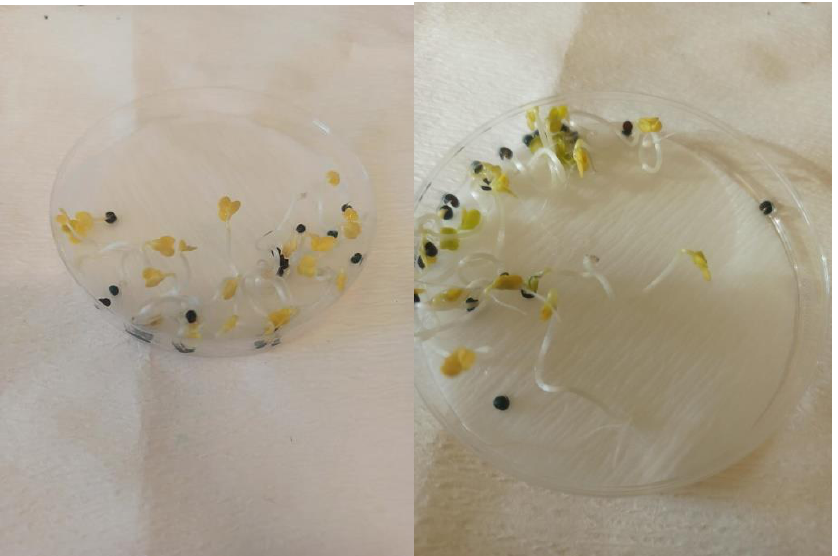
Figure 10. Photos of seed germination in a Petri dish at 20 °C. High values of germination and seedling growth were recorded at this temperature.